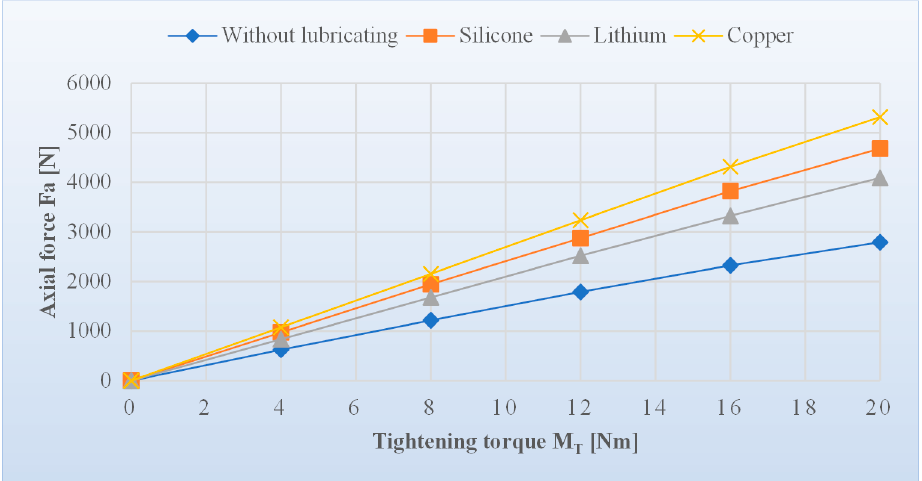
Figure 12. Dependence of the loading tightening torque on the emerging axial force with and without lubricating grease.